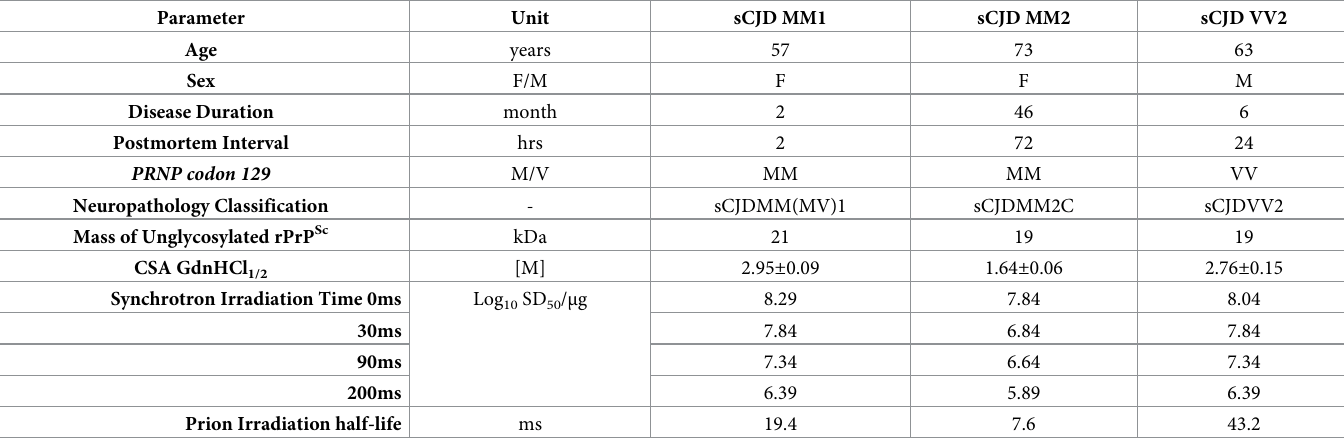
Table 1. Demographics, molecular characteristics, and synchrotron hydroxyl radical inactivation of different strains of sCJD prions. Conformational stability assay (CSA) of prions is expressed in a midpoint concentration of the GdnHCl in the transition from folded to unfolded state [24, 29, 30, 39]. Parameter Unit sCJD MM1 Age years Sex F/M M Disease Duration month Postmortem